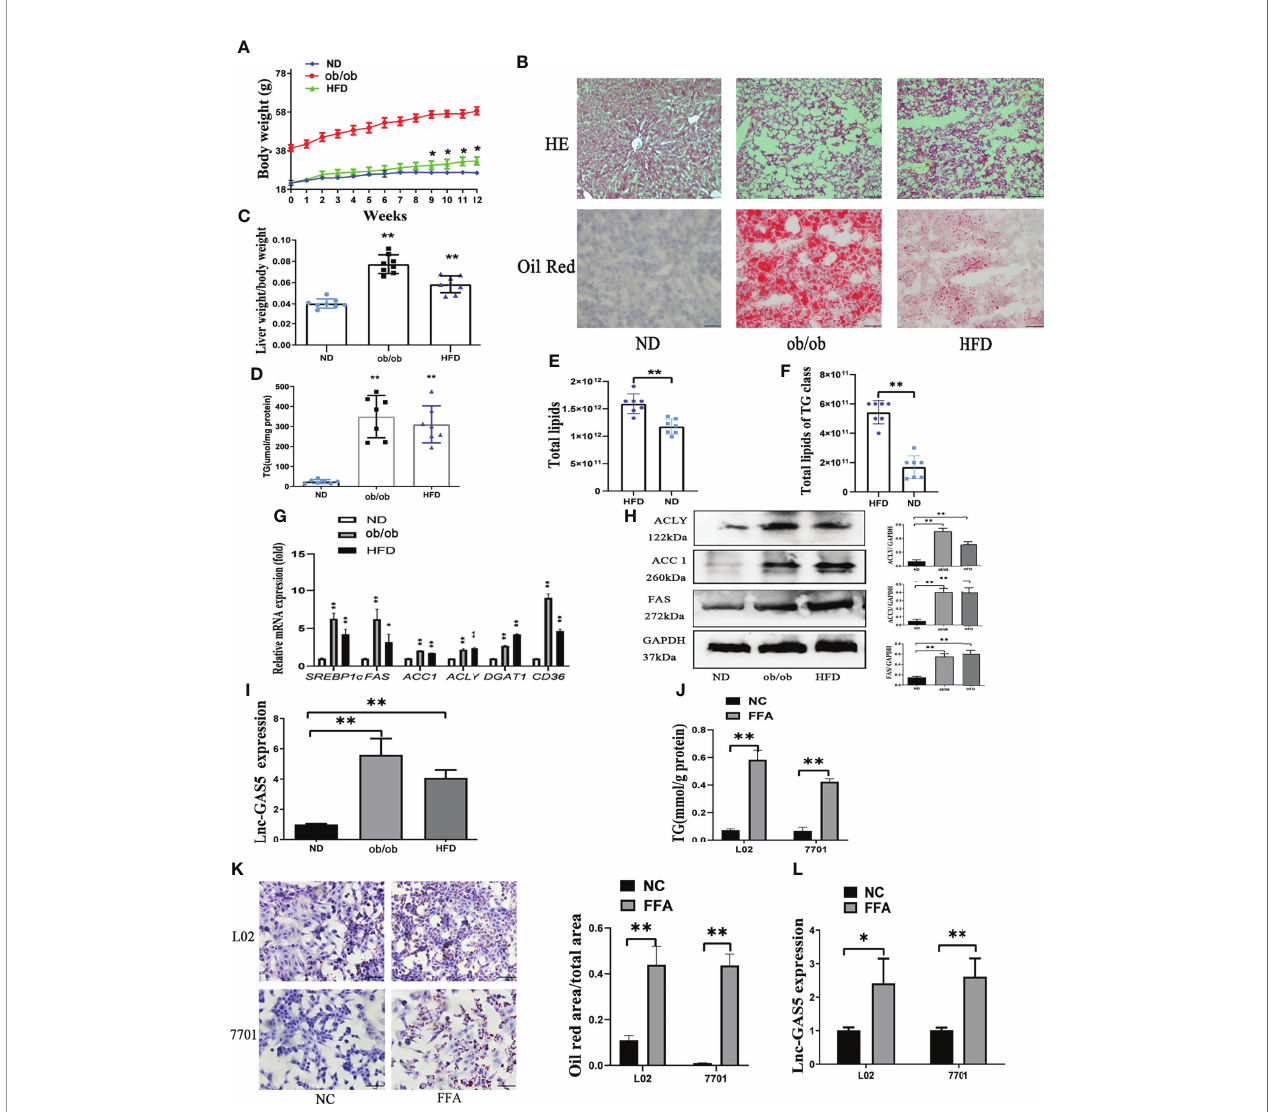
FIGURE 1 | The expression of long non-coding RNA growth arrest speci fi c 5 (GAS5) in in vivo and in vitro non-alcoholic liver disease (NAFLD) models. The body weight of mice in normal chow diet (ND), obese (ob/ob) and high fat diet (HFD) groups were recorded (A) . After 12 weeks of HFD treatment, livers were collected for haematoxylin and eosin staining and oil red staining (Original magni fi cation, ×200) (B) . The ratio of liver weight to body weight was calculated (C) . Levels of triglycerides (TGs) in the liver tissues were detected using commercial kits (D) . Total lipids in HFD and ND fed mice and TG concentration was detected using mass spectrometry (E, F) . The gene expression of SREBP-1c, FAS, ACC1, ACLY, DGAT1 and CD36 was detected using quantitative real-time polymerase chain reaction (RT-qPCR) (G) . Protein expression of ACLY, ACC1 and FAS was determined using western blotting (H) . Expression of GAS5 in ND, ob/ob and HFD mice were detected using RT-qPCR (I) . TG levels (J) , oil red staining (Original magni fi cation, ×200) (K) , and lnc-GAS5 expression (L) of cells treated with FFA. Data are expressed as mean ± standard error of mean. * P < 0.05 and ** P < 0.01; n = 7 in C-F and n = 3 in